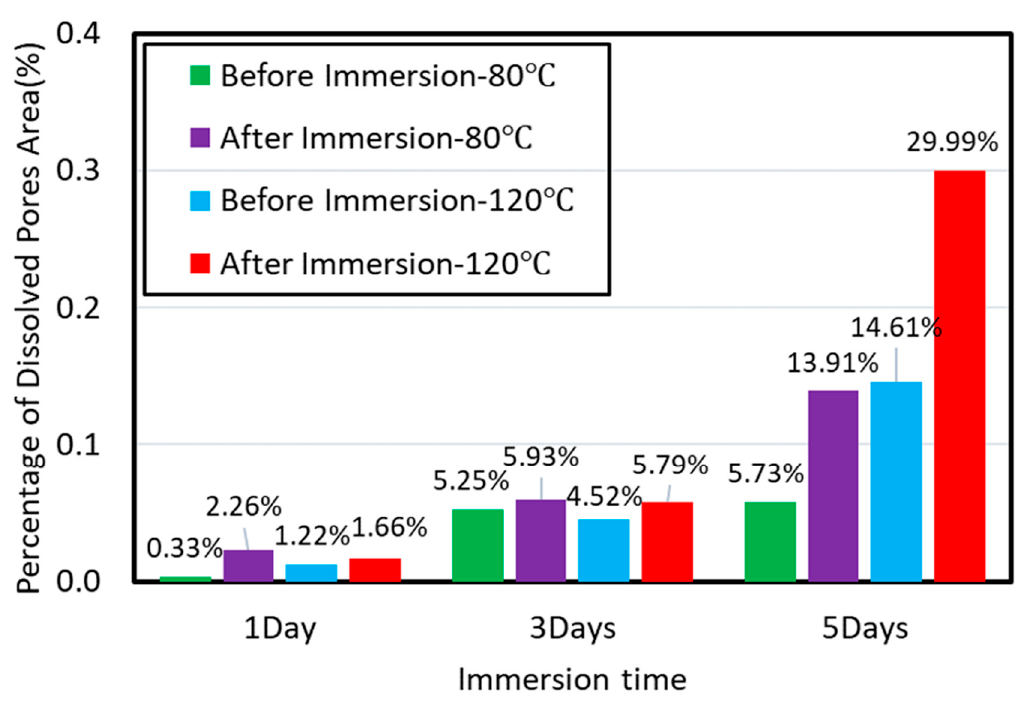
Figure 10. The percentage of dissolved pores area on sample surface varies with time at pressure of 3.5 Mpa and temperature of 80 and 120 °C .